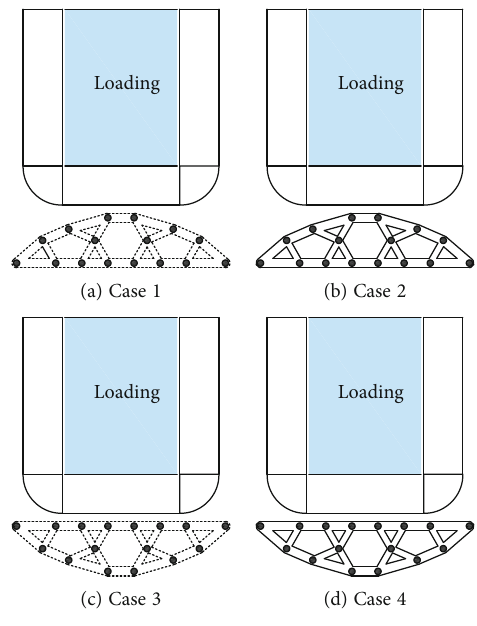
Figure 7: Experimental conditions.